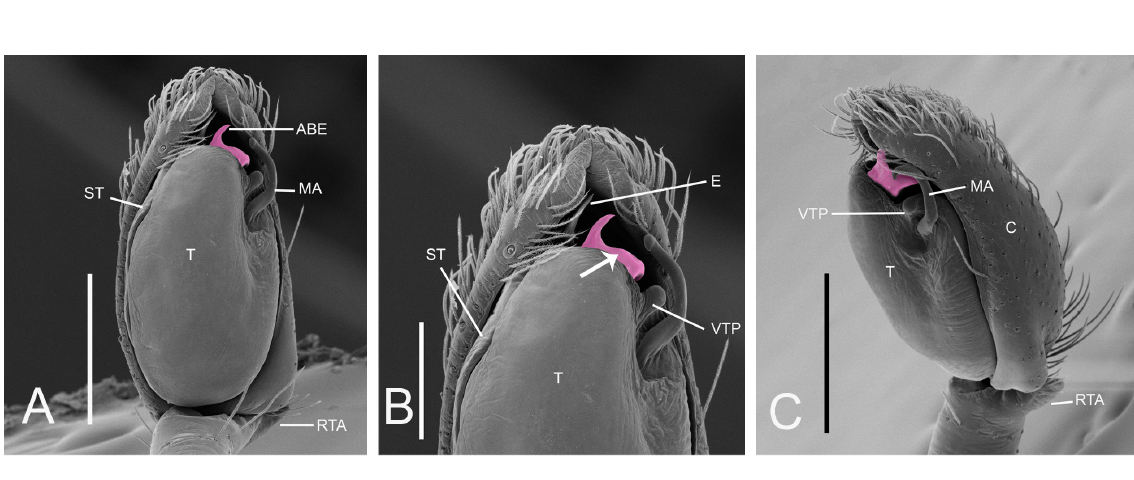
Fig. 18. Tafana nevada sp. nov., ♂ (IBNP). A . Left palp, ventral view. B . Left palp, ventral view (arrow indicating the base of the embolus). C . Left palp, retrolateral view. Abbreviations: ABE = apophysis of base of the embolus; C = cymbium; E = embolus; MA = median apophysis; RTA = retrolateral tibial apophysis; ST = subtegulum; T = tegulum; VTP = ventral tegular process. Scale bars: A, C = 0.4 mm; B = 0.2